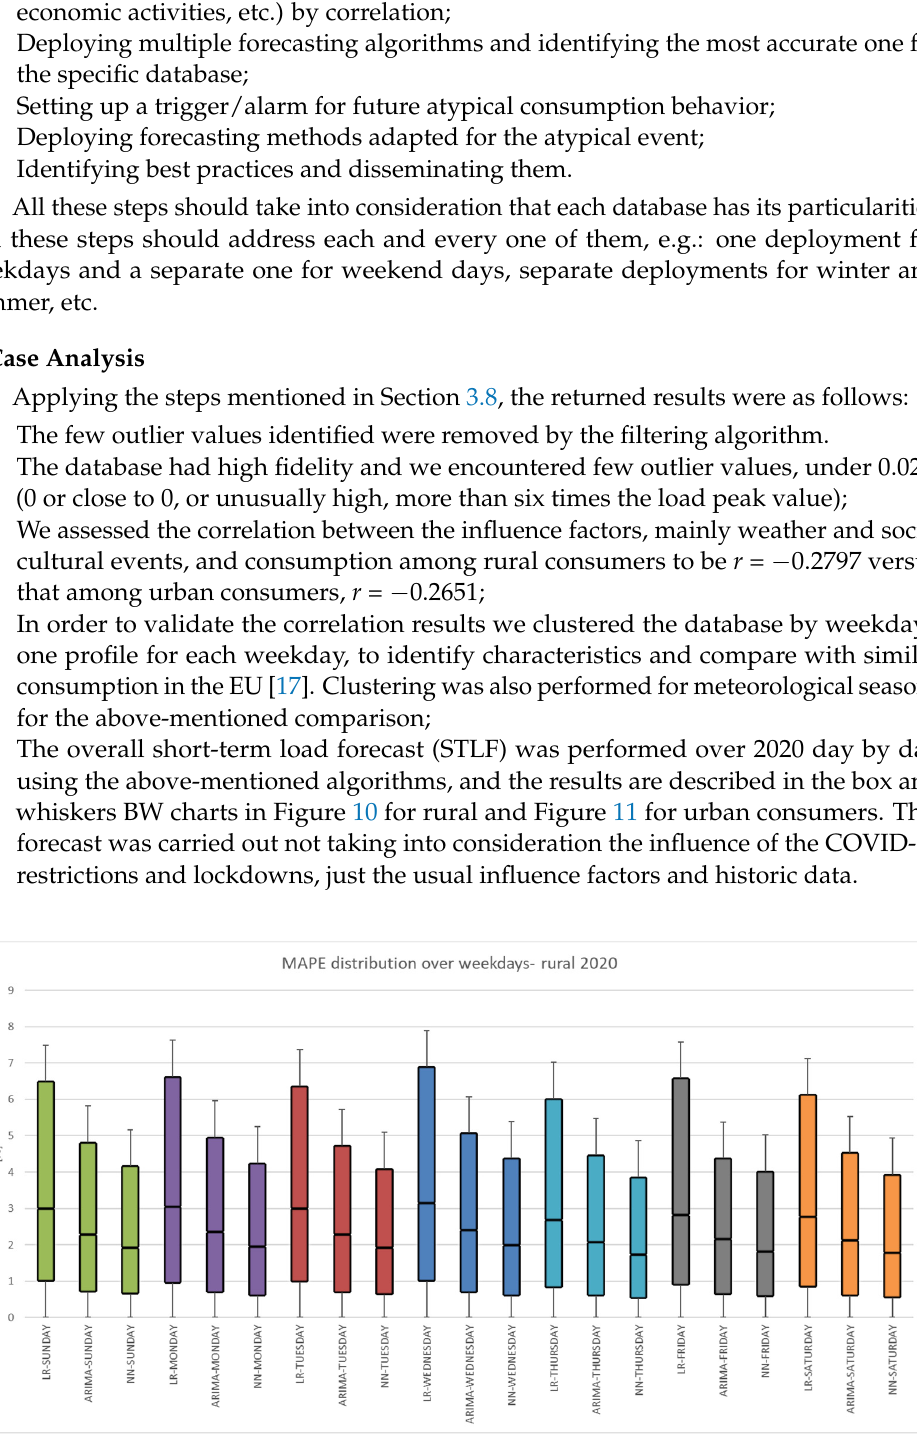
Figure 11. Overall forecasting results for urban consumers in 2020. 6.